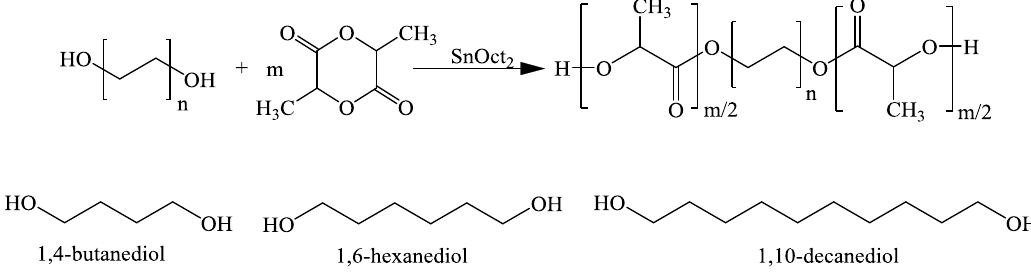
Figure 1. Ring opening reaction scheme of L -lactide with diol ring openers.